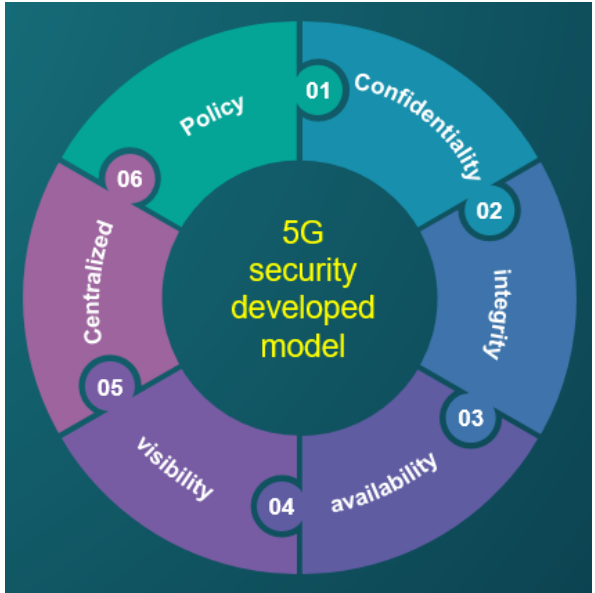
Figure 4. A 5g developed security